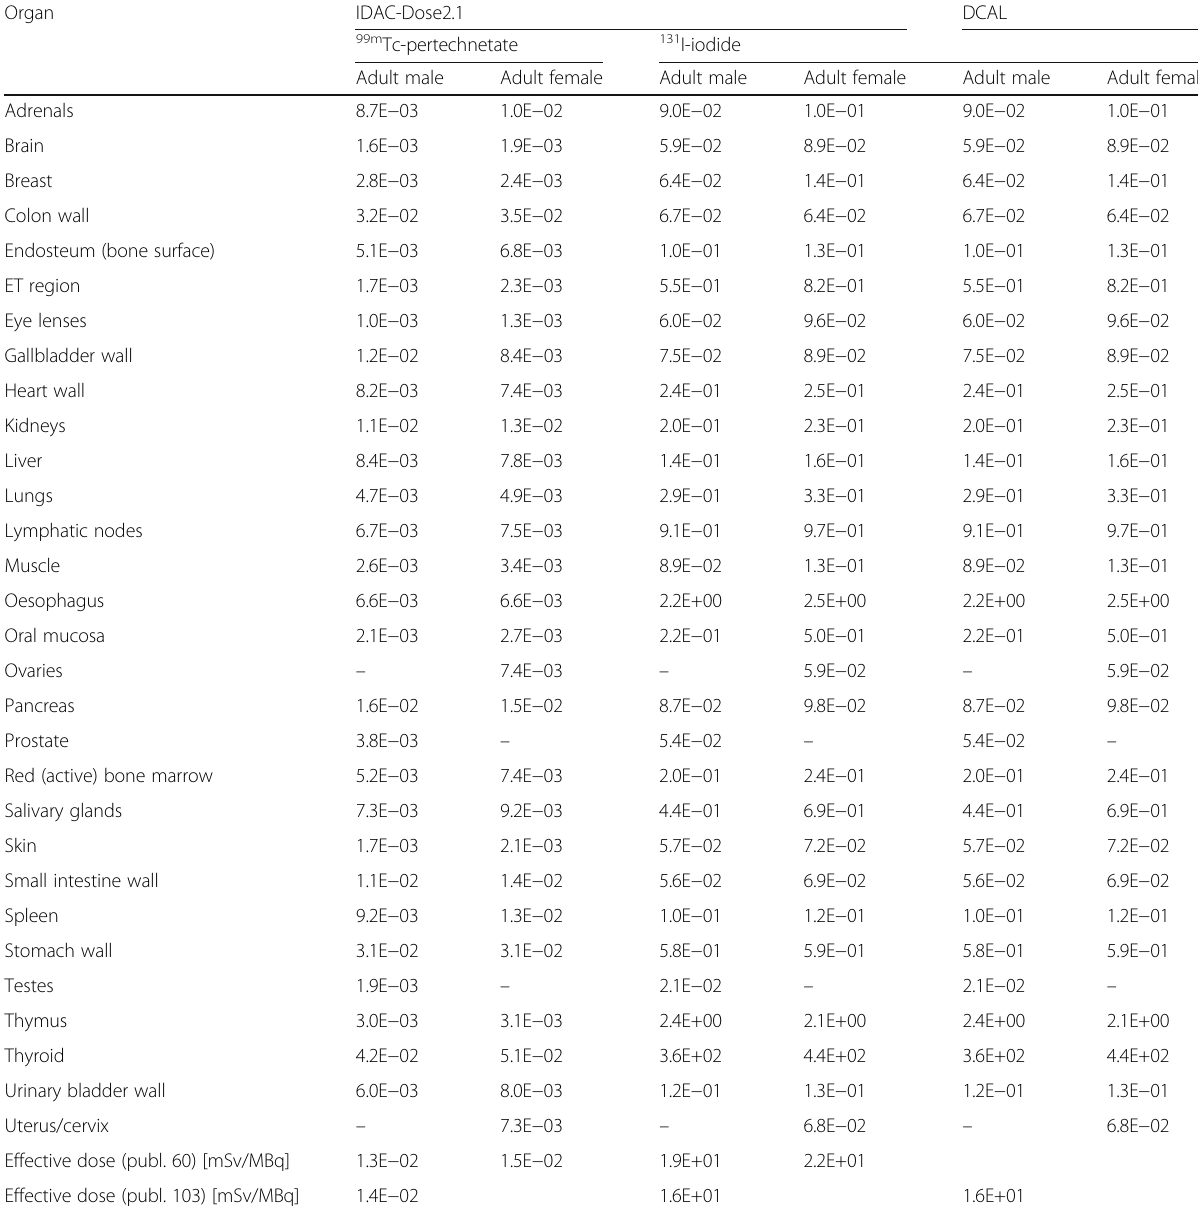
Table 1 Absorbed dose per unit of orally administered 99m Tc-pertechnetate and 131 I-iodide activity calculated with IDAC-Dose2.1 or